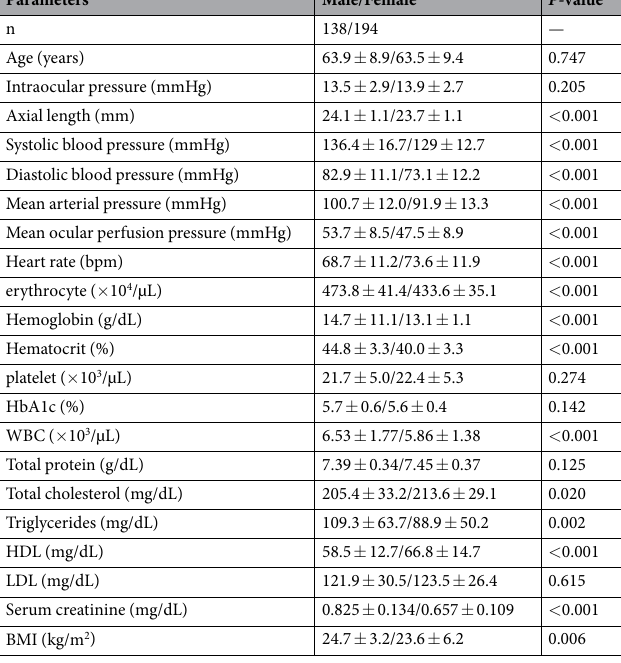
Table 1. Clinical characteristics of all